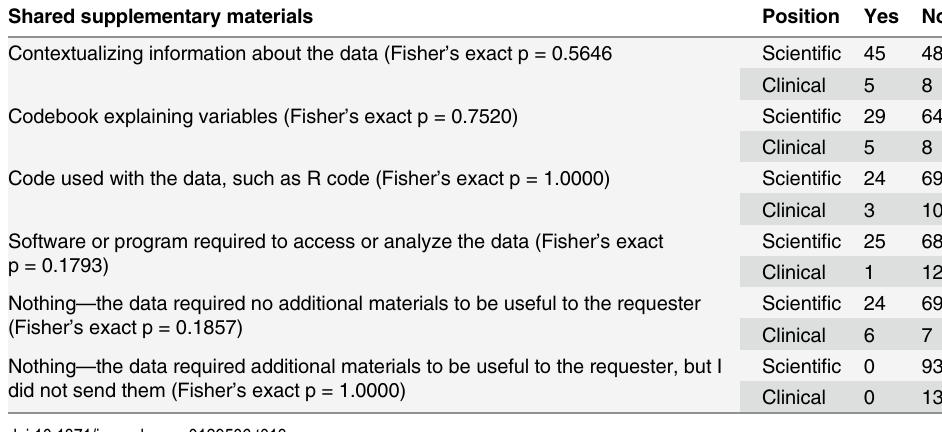
Table 13. Scientific group vs. Clinical group: supplementary materials they provided in data